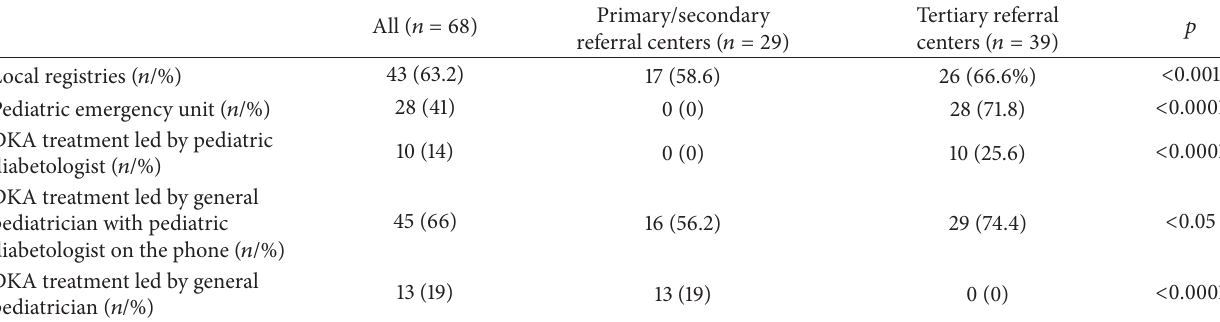
Table 2: Diabetic ketoacidosis incidence in the whole pediatric population (0–18 years) in the calendar years 2012 and 2013 in Italy. Primary/secondary All ( 𝑛 = 68 )